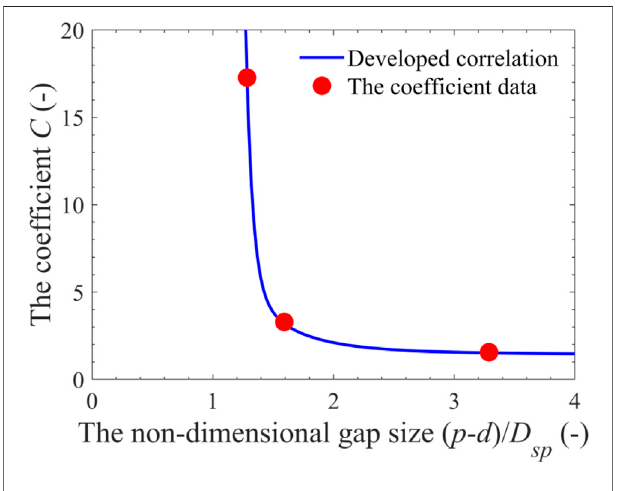
FIGURE 15 | Fitting curve for the coef fi cient C . FIGURE 16 | Veri fi cation of the transition